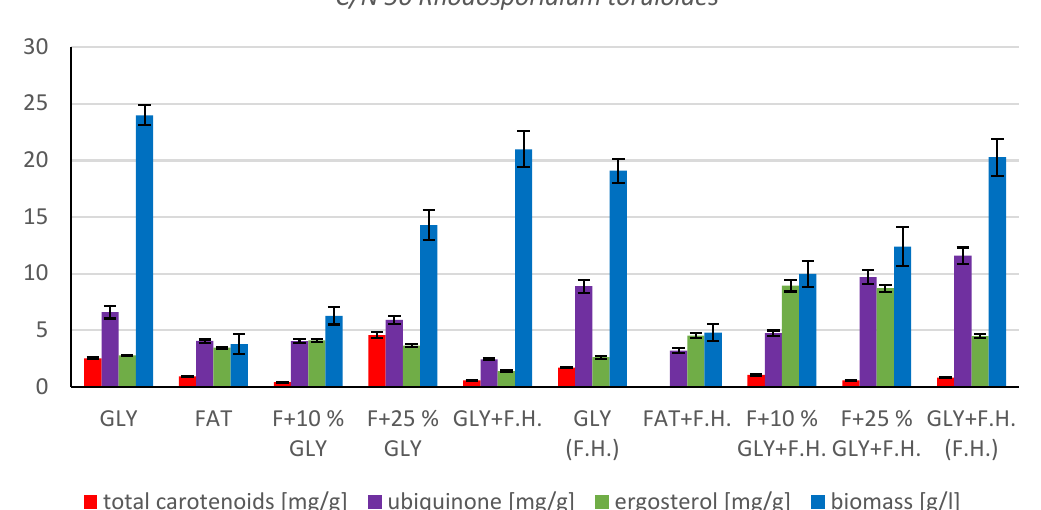
Figure 4. Metabolite production by biomass of yeast strain Rhodotosporidium toruloides in conditions of C/N ratio 50.